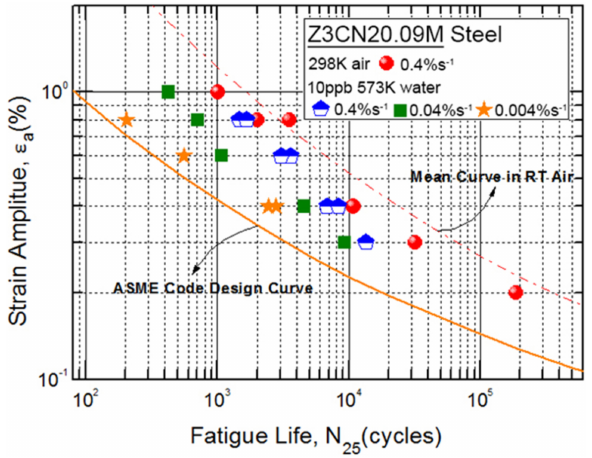
Figure 4. Fatigue life of the Z3CN20.09M ASS in water at 300 ◦ C.